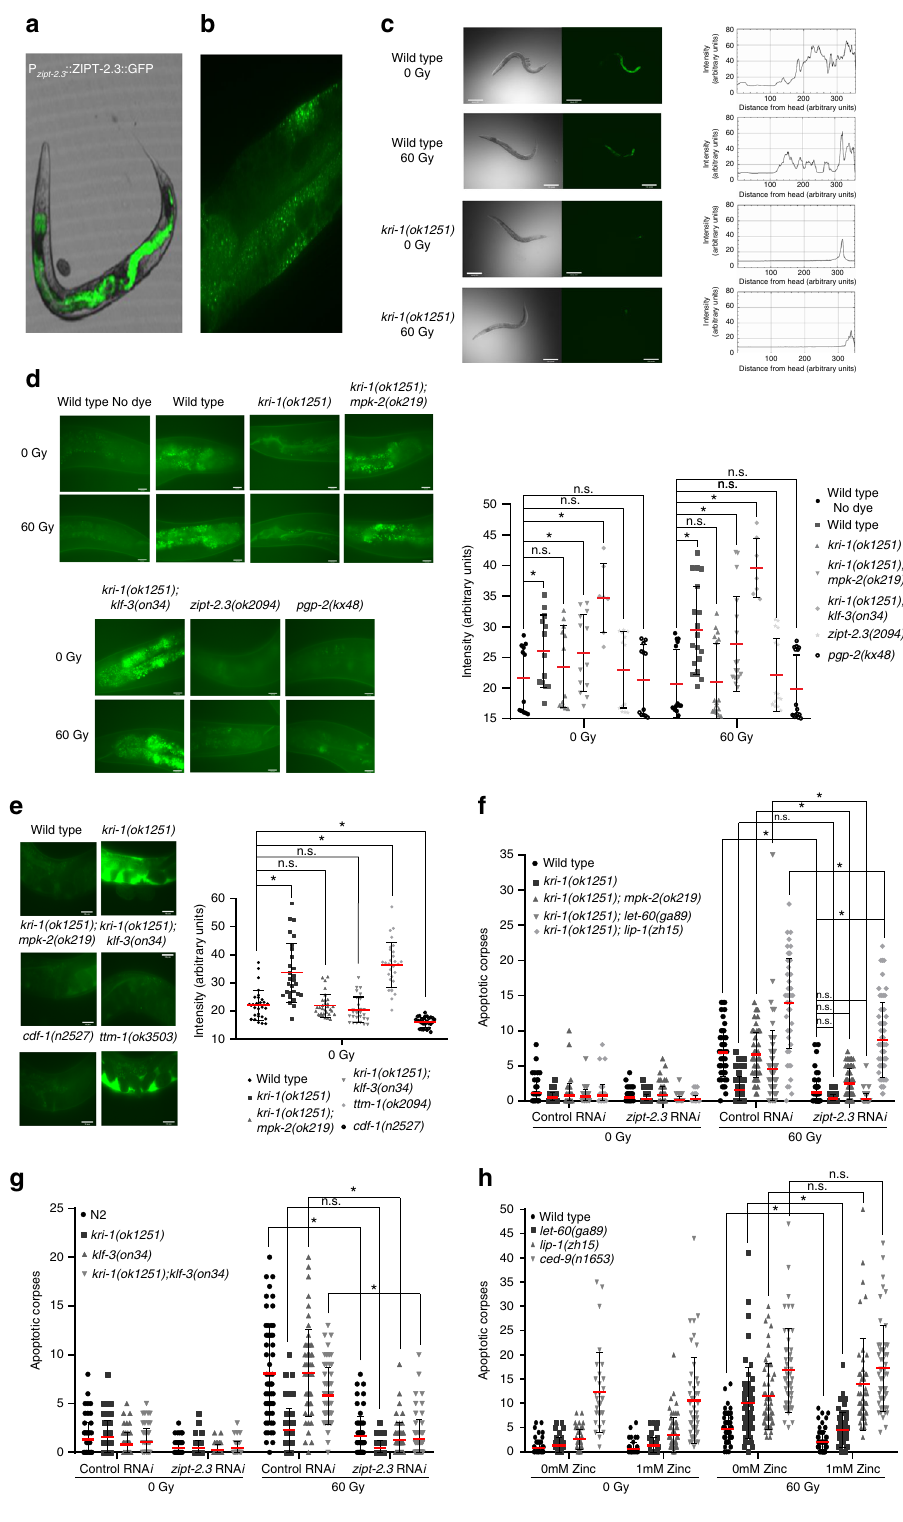
3 , we knocked-down zipt-2.3 in kri-1(ok1251); mpk-2(ok219) , and (ok3505) mutants and stained cdf-1(n2527) animals for reduced kri-1(ok1251); klf-3(on34) double mutant worms and observed a body cavity zinc 38 . These results suggest that the failure to properly store zinc in the intestine of kri-1(ok1251) mutants leads similar reduction in apoptosis as knocking-down zipt-2.3 in wild to higher levels in the body cavity. type animals (Fig. 5f, g). Immunostaining germlines of wild type and kri-1(ok1251); mpk-2(ok219) worms for dp-MPK-1 upon zipt-2.3 RNA i knock-down revealed a reduction of activated ZIPT-2.3 promotes IR-induced MPK-1 activation and apop- MPK-1 (Supplementary Fig. 5A), indicating that zipt-2.3 tosis . To con fi rm that zipt-2.3 acts downstream of mpk-2 and klf- NATURE COMMUNICATIONS| (2019) 10:1791